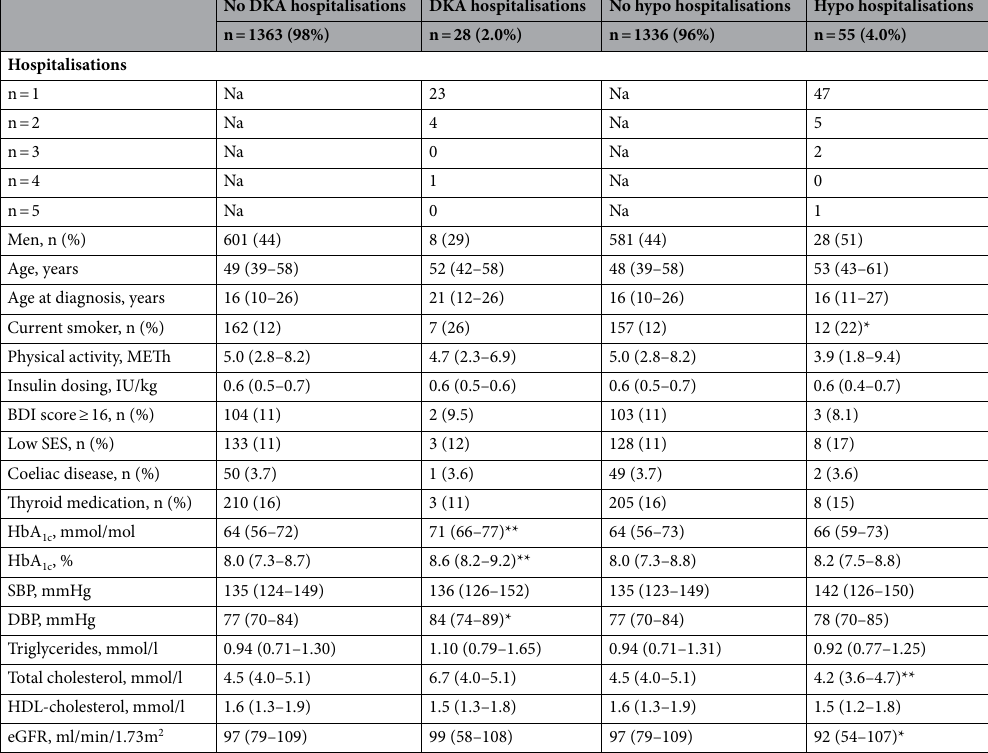
Table 1. Participant characteristics divided by the hospitalisation status. Data are presented as frequency for categorical variables, and median (interquartile range) for continuous variables with skewed distribution. Using Chi-squared test and Mann–Whitney U-test, for the respective variable types, we compared those with each hospitalisation type and those with no hospitalisations. DKA diabetic ketoacidosis, Hypo hypoglycaemia, METh metabolic equivalent of task hour, BDI Beck Depression Inventory, scores ≥ 16 are indicative of signs of depression, Low SES low socioeconomic status, unskilled blue collar workers, SBP systolic blood pressure, DBP diastolic blood pressure, eGFR estimated glomerular filtration rate. * p < 0.05; ** p <